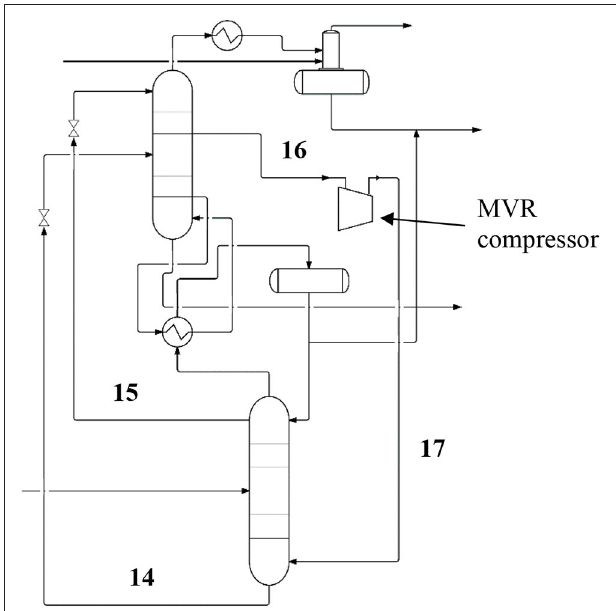
FIGURE 4 | A simplified diagram showing the complete system featuring the reactor and the gas sparger unit, split column arrangement, and the mechanical vapor recompression unit. The labels and stream flows identified in Figures 2 , 3 apply to this diagram and are omitted for clarity. The additional process labels relating to the mechanical vapor recompression unit are included here and the additional stream flow numbering labels are as follows: (14) Lean methanol; (15) Rich methanol reflux to LP; (16 and 17) Recycle